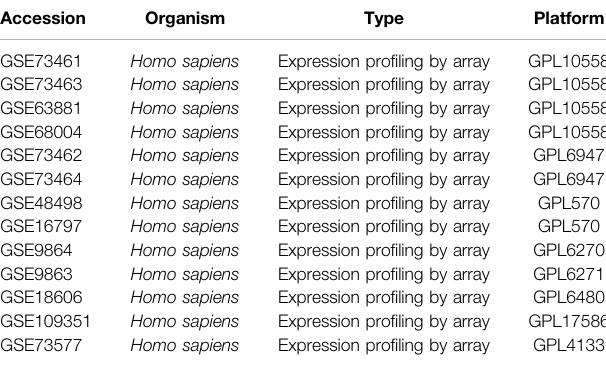
TABLE 1 | Search result GEO datasets using the ARGEOS web